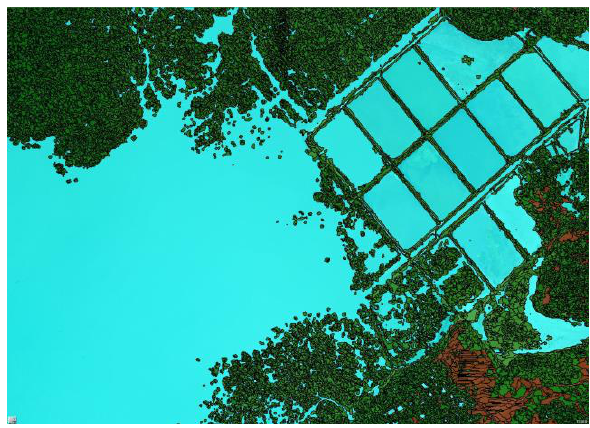
Figure 11b. Image showing merged segments classified as Water for both sea and aquaculture ponds. This was done since Water segments greater than 1,000,000 pixels represented the sea, hence classified as Sea (see Fig. 11c).